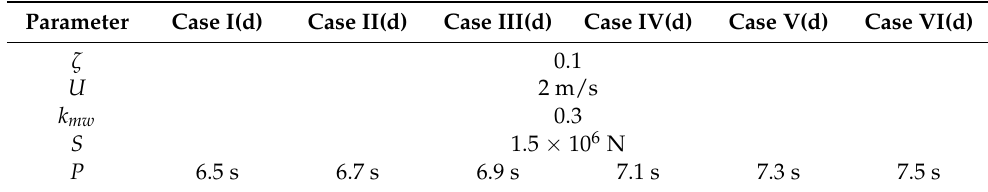
Table 3. Detailed parameters of different